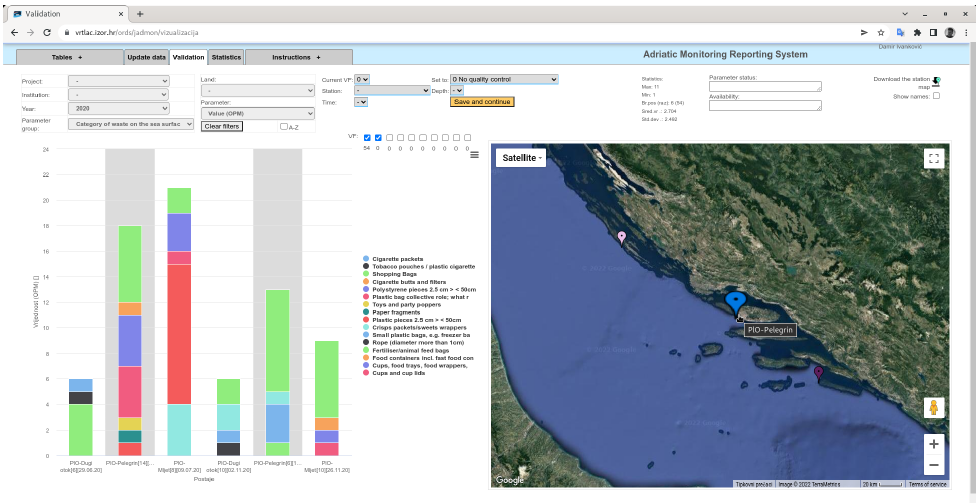
Figure 12. Example of marine litter categories